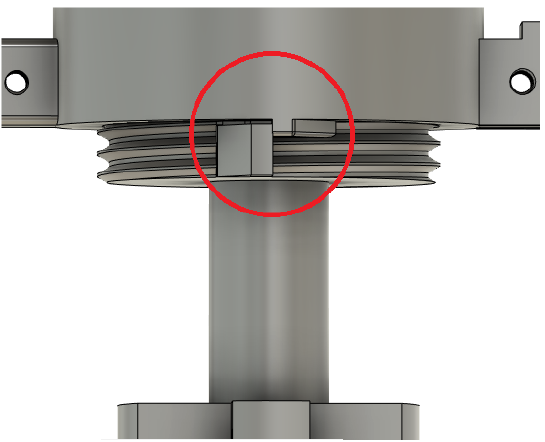
Figure 9. We installed two protective barriers on the cover frame and the ID shaft. This figure shows the model of the two protective barriers (the parts inside the red